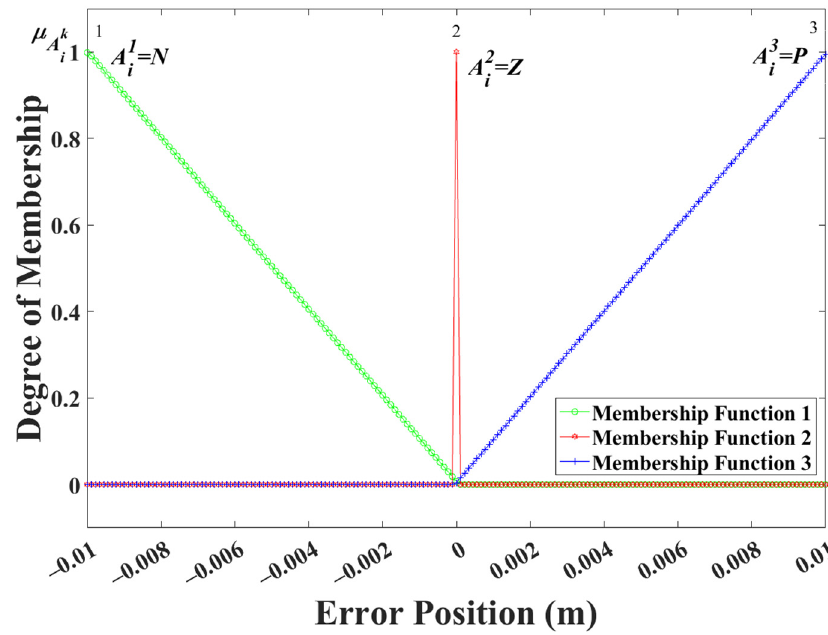
Figure 2. Input membership function of the fuzzy set for FBBRC and FLC.